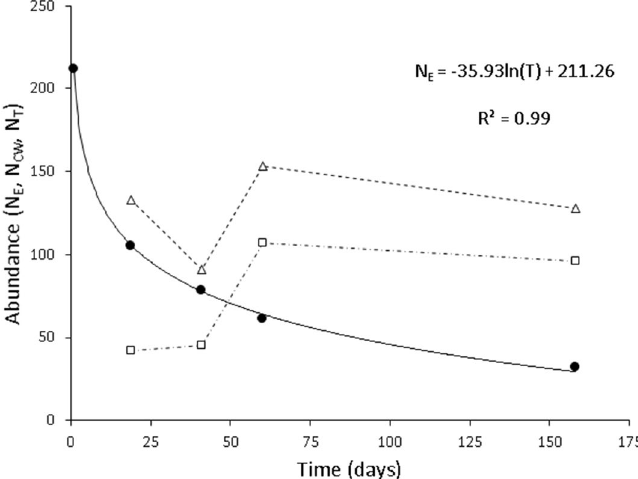
Figure 2. Residency decay of experimental fish (solid circles) in the study area (− 600, + 500 m from the release point). Residency was calculated as the minimum number of experimental fish present in the study section (fish captured at each sampling date or later). The solid line represents the fitting of a logarithmic model. Open squares are numbers of wild fish captured at each time, and triangles are total captures (wild and experimental